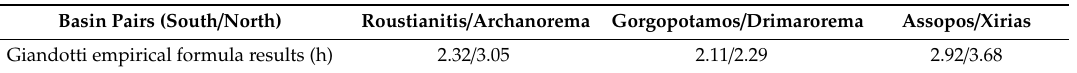
Table 3. The calculated values of Giandotti formula for the comparable pairs of the southern and northern sub-catchments.